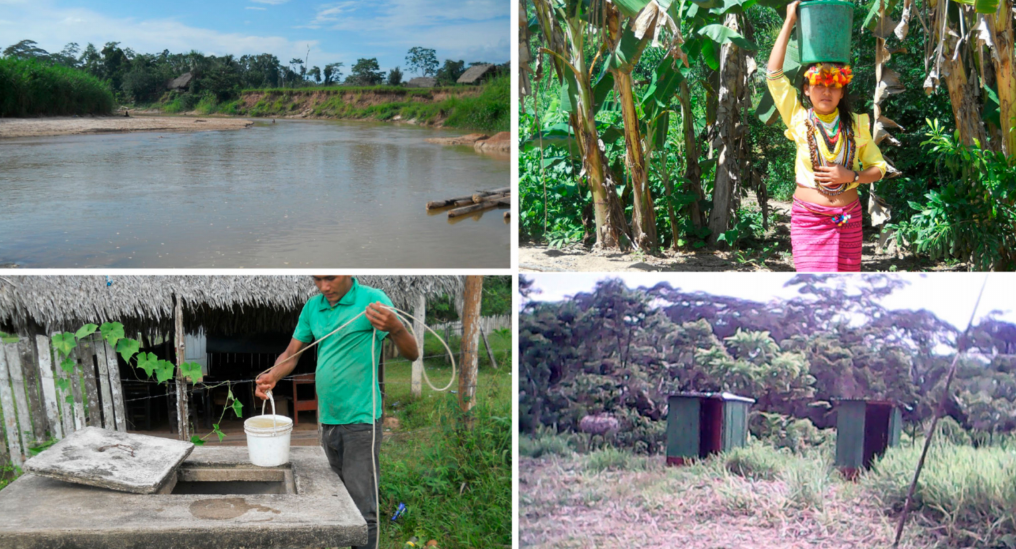
Figure 3. Photographs from transect walking paths in Shawi communities in Yurimaguas, Armanayacu River and basin, Peru. All photos taken and used with informed